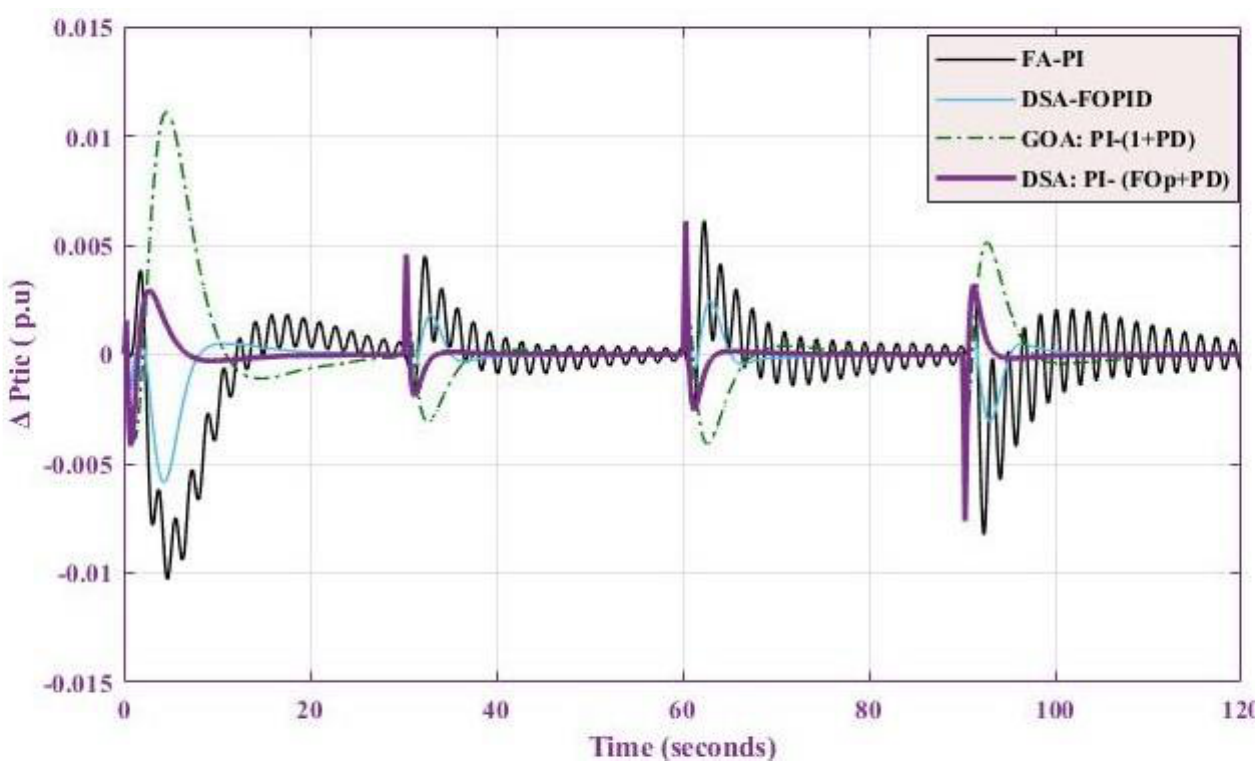
Figure 15. Tie-line power sharing.